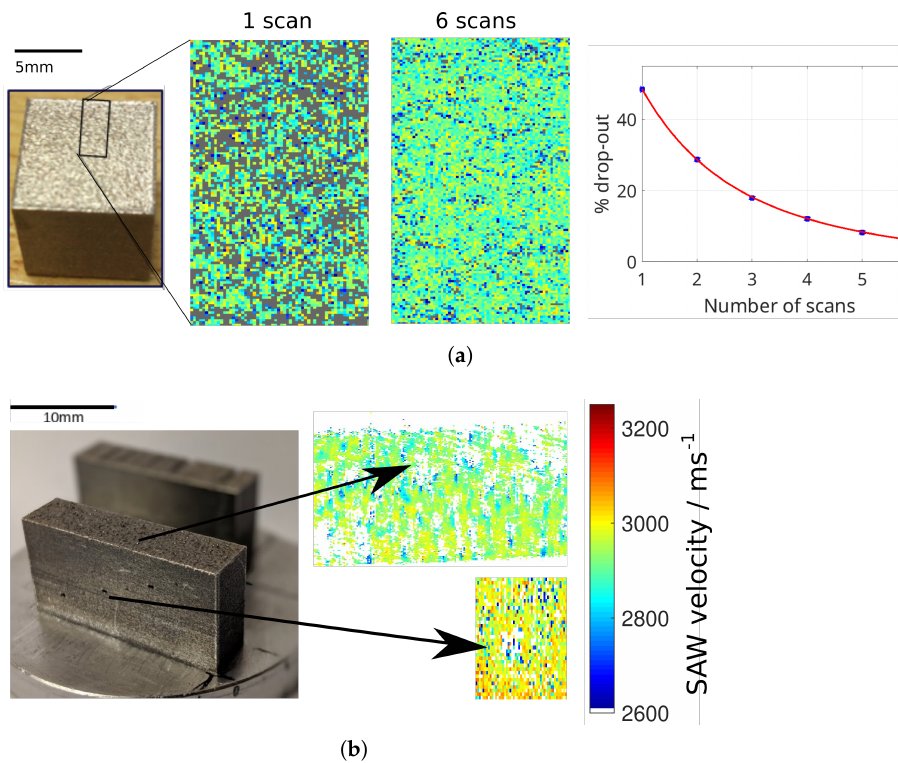
Figure 9. LPBF: ( a ) Ti-6Al-4V, acquired using the SKED showing that combining scans with different detector positions can reduce data loss. ( b ) Al sample with designed defects measured on the top and side wall with the Quartet